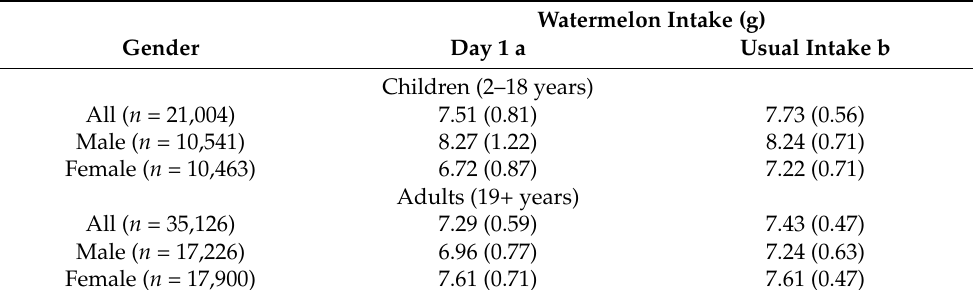
Table 2. Intake of watermelon (grams/day) per capita of children (2–18 years) and adults (19+ years), NHANES